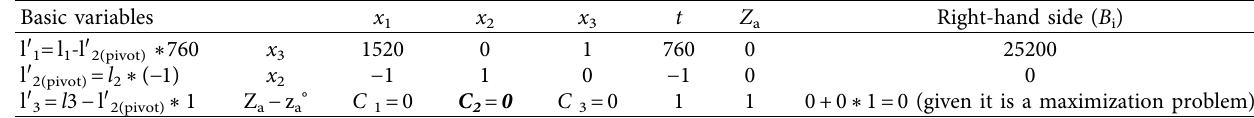
Table 3: The final Simplex table in phase I.